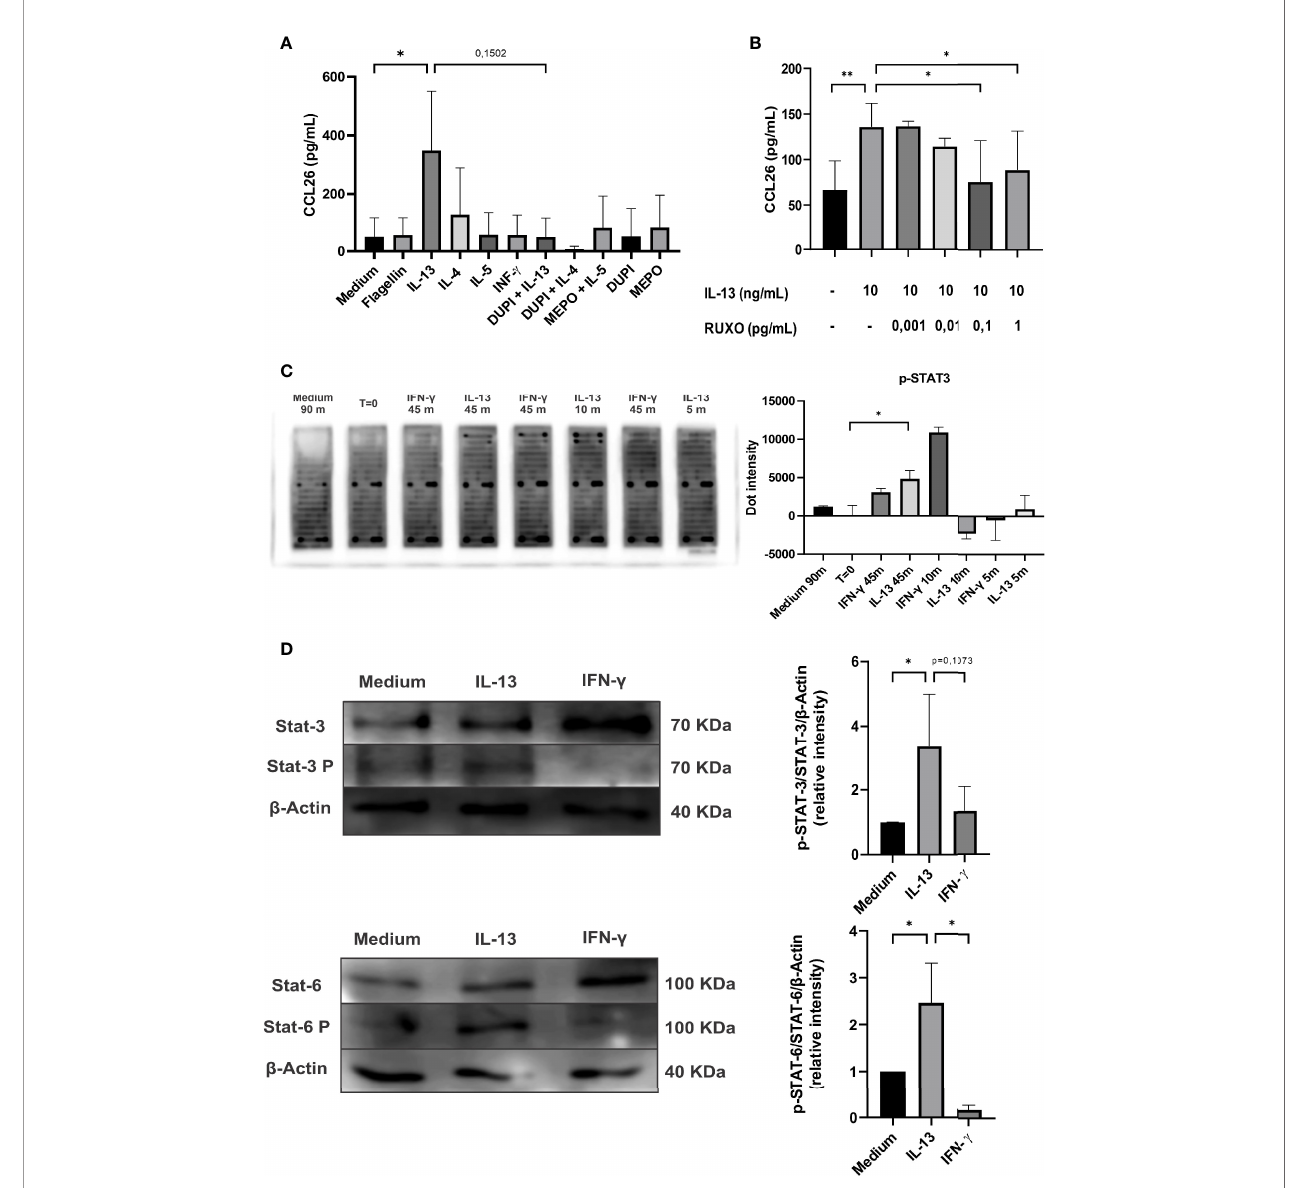
FIGURE 4 | Analysis of CCL26 production by Caco-2 cells in response to type-1 and -2 cytokines. (A) Chemokine quanti fi cation was measured in the culture supernatants by ELISA after 48h of cytokine stimulation. Blocking antibodies were used (DUPI: Dupilumab or anti IL-4 a R monoclonal antibody; MEPO: Mepolizumab or anti-IL-5 monoclonal antibody). (B) IL-13-induced CCL26 secretion was inhibited with RUXO (Ruxolitinib or JAK1/2 inhibitor). (C) Image of array slides of Caco-2 cell lysates after IL-13 (10 ng/ml) or IFN- g (10 ng/ml) stimulation at different time-points (0, 5, 10, 45 minutes). Quanti fi cation of the array signal for phosphorylated STAT3 is shown. (D) Immunoblot analysis for STAT3 and STAT6 activation on lysates from Caco-2 cells stimulated with IL-13 (10 ng/ml) or IFN- g (10 ng/ml) for 90min. Semi-quantitative analysis of the results are shown as pSTAT-6/STAT-6/ b -actin and pSTAT-3/STAT-3/ b -actin signal intensity ratios. Each column represents mean ± standard error (* P < 0,1, ** P <